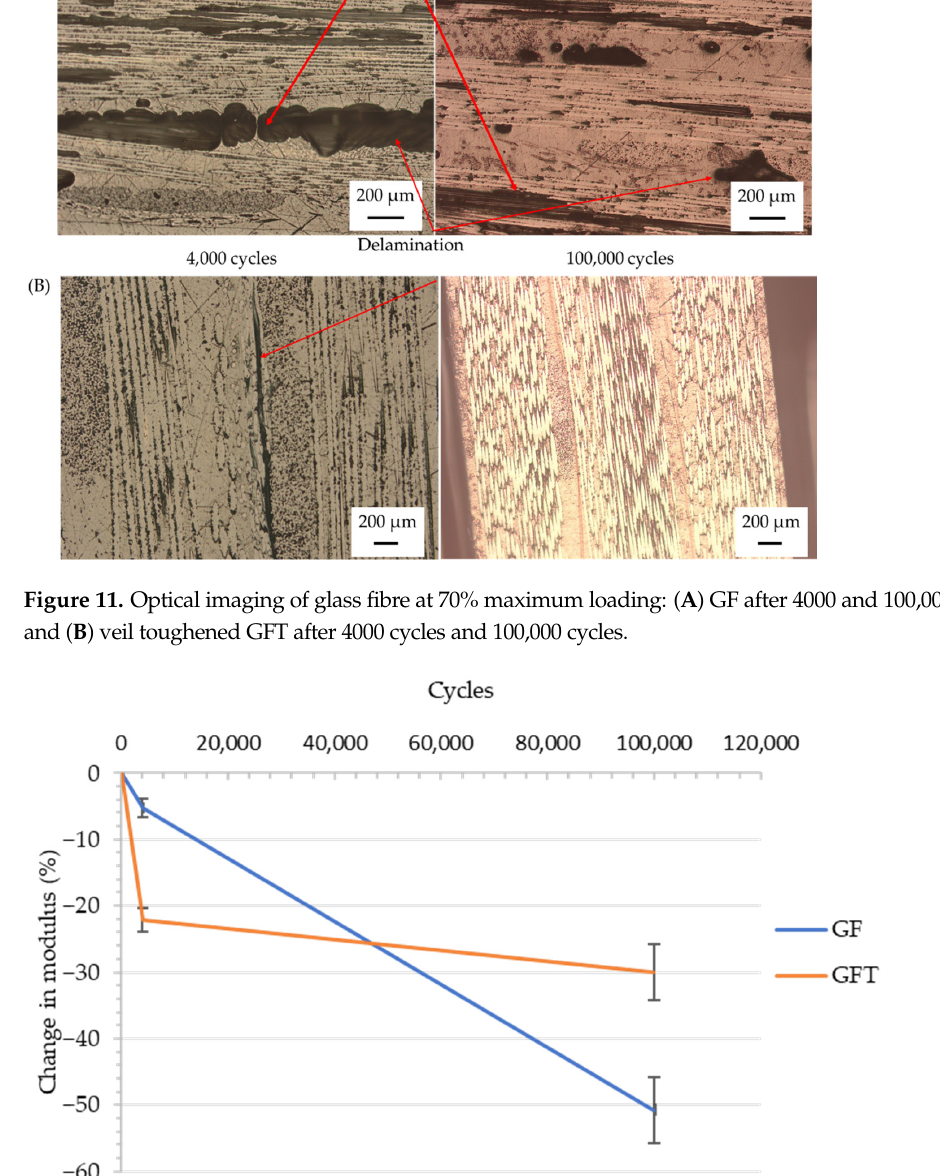
Figure 13. Glass fibre samples tested under cyclic loading at 50%, 70%, and 90% of their maximum loading. For GF the maximum flexural strength for each percentage was 260, 360, and 600 MPa, respectively. The results in Figure 14 indicate that matrix failure in GFT does not occur until higher stress amplitudes than GF. With 70% GFT showing less failure progression with the